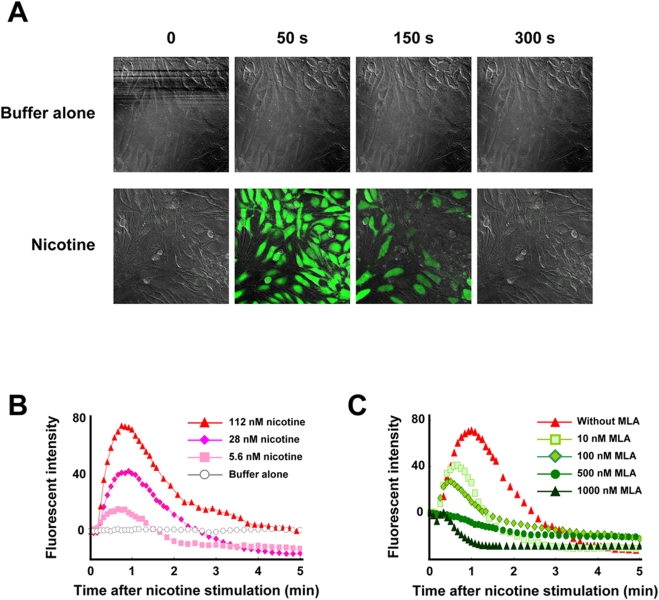
Calcium influx assay in primary chondrocyte culture.Nicotine-stimulated calcium signaling was investigated by the use of a fluorescent Ca2+ indicator. Primary chondrocyte cultures were stimulated by nicotine with or without MLA, the specific antagonist of alpha7 homomeric nAChR. A: Addition of assay buffer alone elicits no reaction (upper panels: negative control). Nicotine elicits a transient increase of intra-cellular calcium (lower panels). B: Nicotine elicits a transient increase of intra-cellular calcium in a concentration-dependent manner. C: MLA inhibits nicotine-induced calcium influx in a concentration-dependent manner. The cells were treated with MLA 30 min before nicotine stimulation.